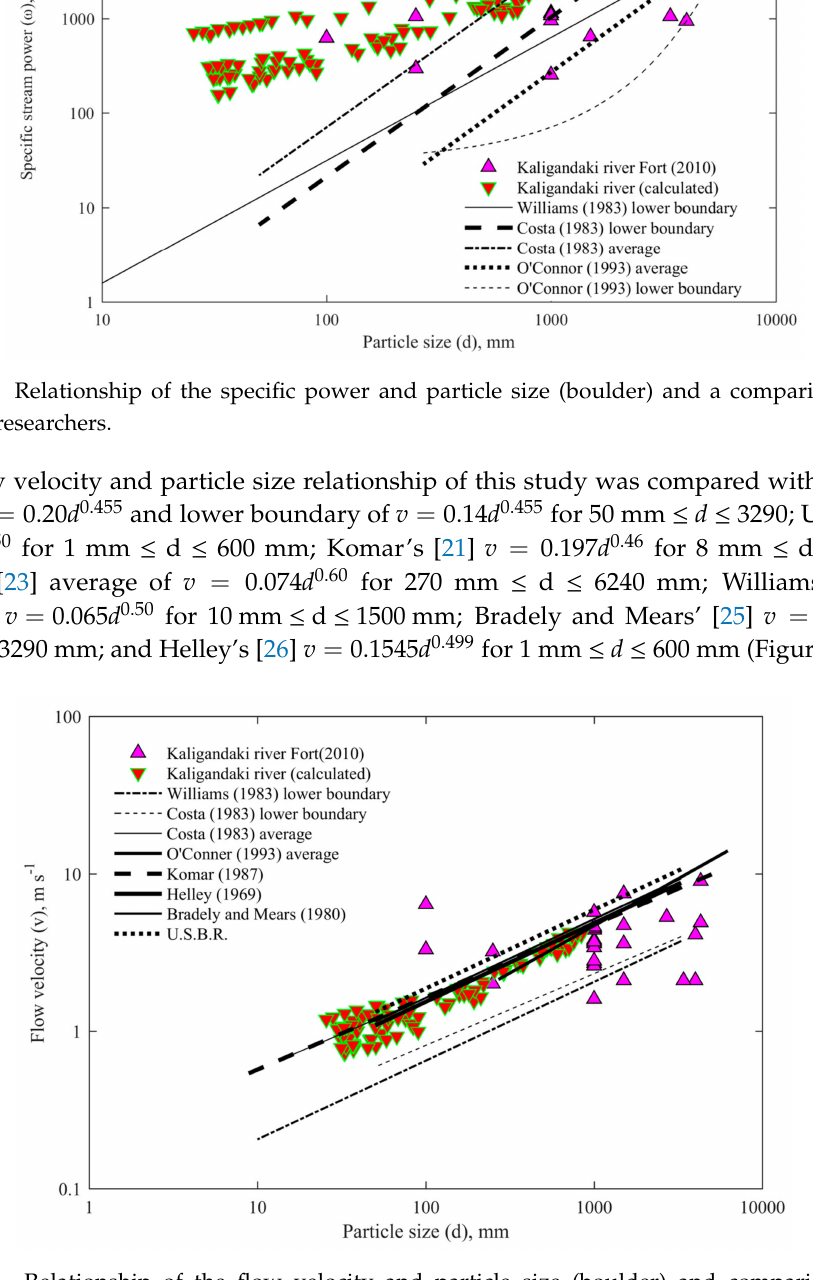
Figure 7. Relationship of the flow velocity and particle size (boulder) and comparison with di ff erent